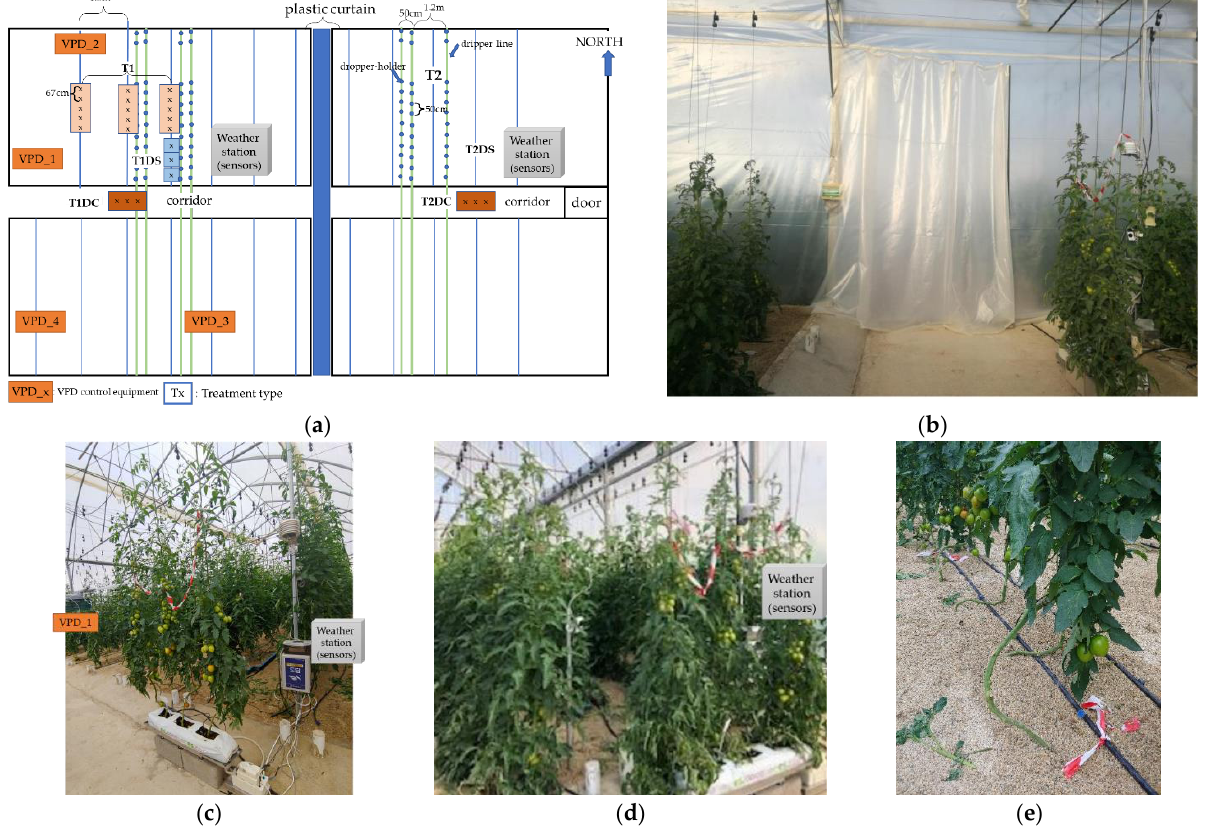
Figure 1. Experimental settings: ( a ) spatial distribution of treatments in the greenhouse; ( b ) plastic curtain separating each area; ( c ) western area of the greenhouse; ( d ) eastern area of the greenhouse; ( e ) paired rows of dripper lines.